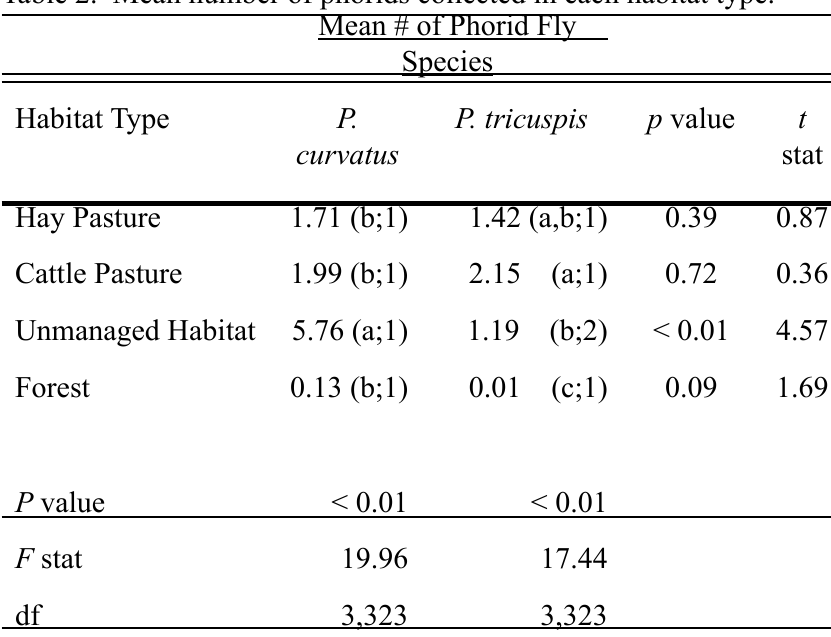
Table 2. Mean number of phorids collected in each habitat type.